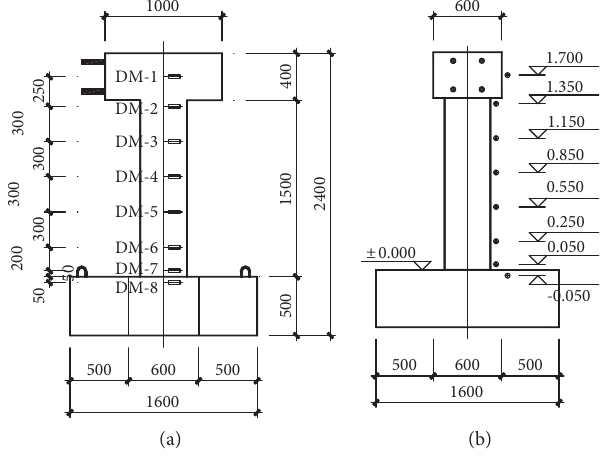
Figure 8: Arrangement of LVDTs. (a) Rear view. (b) Left